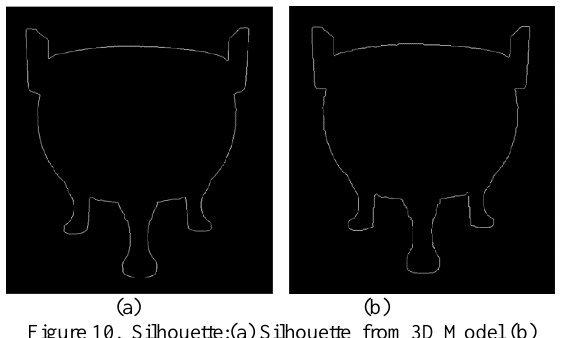
Figure 10. Silhouette:(a) Silhouette from 3D Model (b) Silhouette from Texture Image